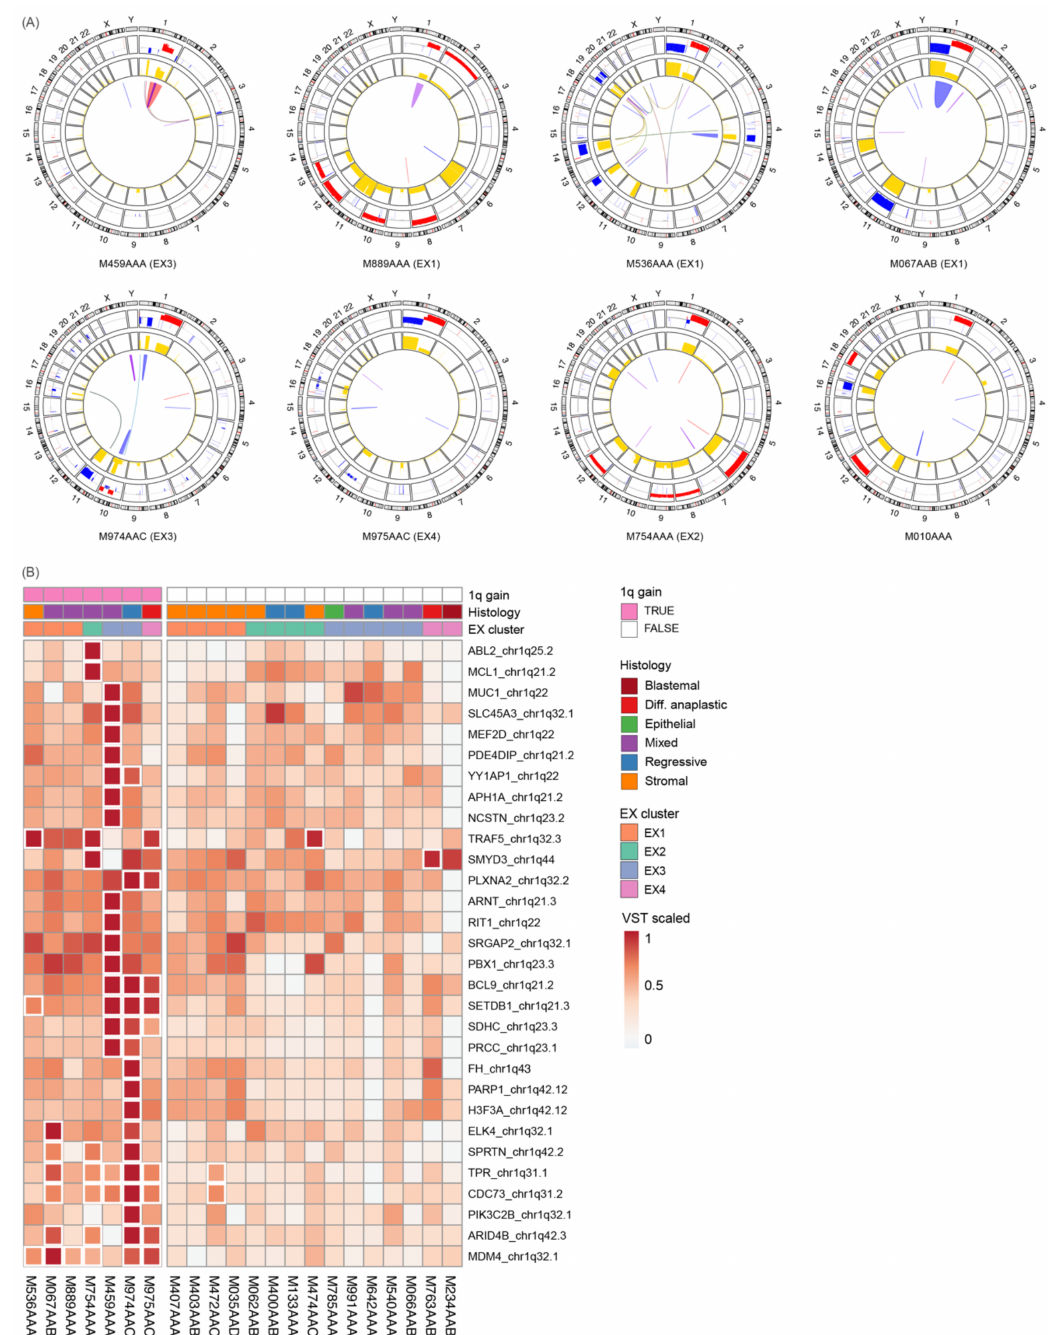
Figure 5. 1q gain can arise through different mechanisms and result in overexpression of specific genes. ( A ) Tumors show different patterns in copy number data and structural variants affecting 1q. For two tumors, we identified underlying SVs: M459AAA has an amplification likely caused by a breakage-fusion-bridge cycle and M889AAA has a large, inverted duplication. The other six tumors carry a stable chromosome arm-level gain. For two of those (M536AAA and M067AAB) we identified SVs that likely occurred subsequently, since the SV breakpoints do not correspond to the CN segments. For the remaining four 1q+ tumors we did not identify large SVs or translocations. ( B ) All 1q+ tumors (pink) upregulate cancer genes located on 1q but also show large differences in which genes are significantly overexpressed (nz-score > 1.98, white border). Expression values are scaled per row to display relative differences among tumors rather than between genes. See Figure S8B for locations of SVs and overexpressed genes on